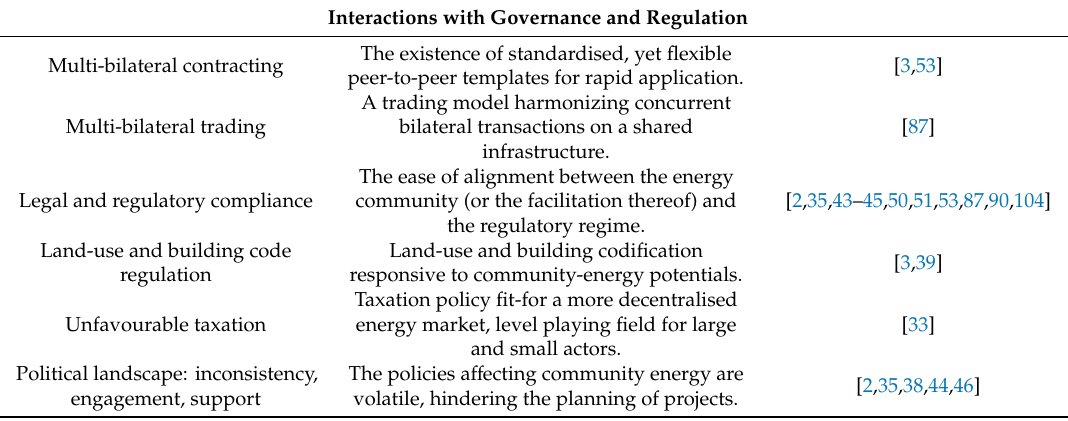
Table 2. Progression factors tied to interactions with governance and